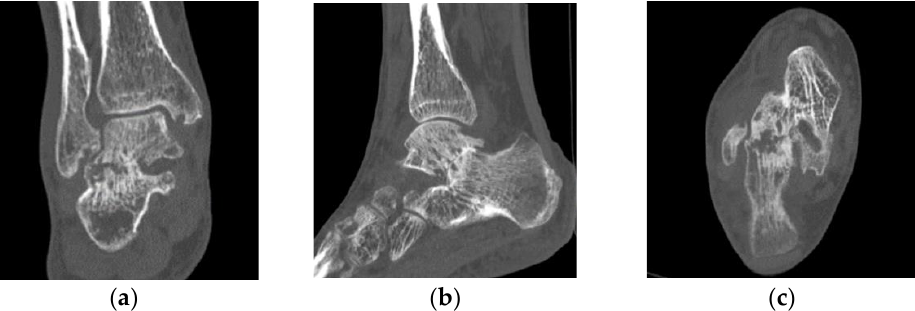
Figure 3. Erosion and destruction of the subtalar joint on computed tomography. Computed tomog- raphy images of the coronal ( a ), sagittal ( b ), and axial ( c ) parts of the subtalar joint. Findings demon- strate narrowed joint space and destruction of the subtalar joint of the right ankle.